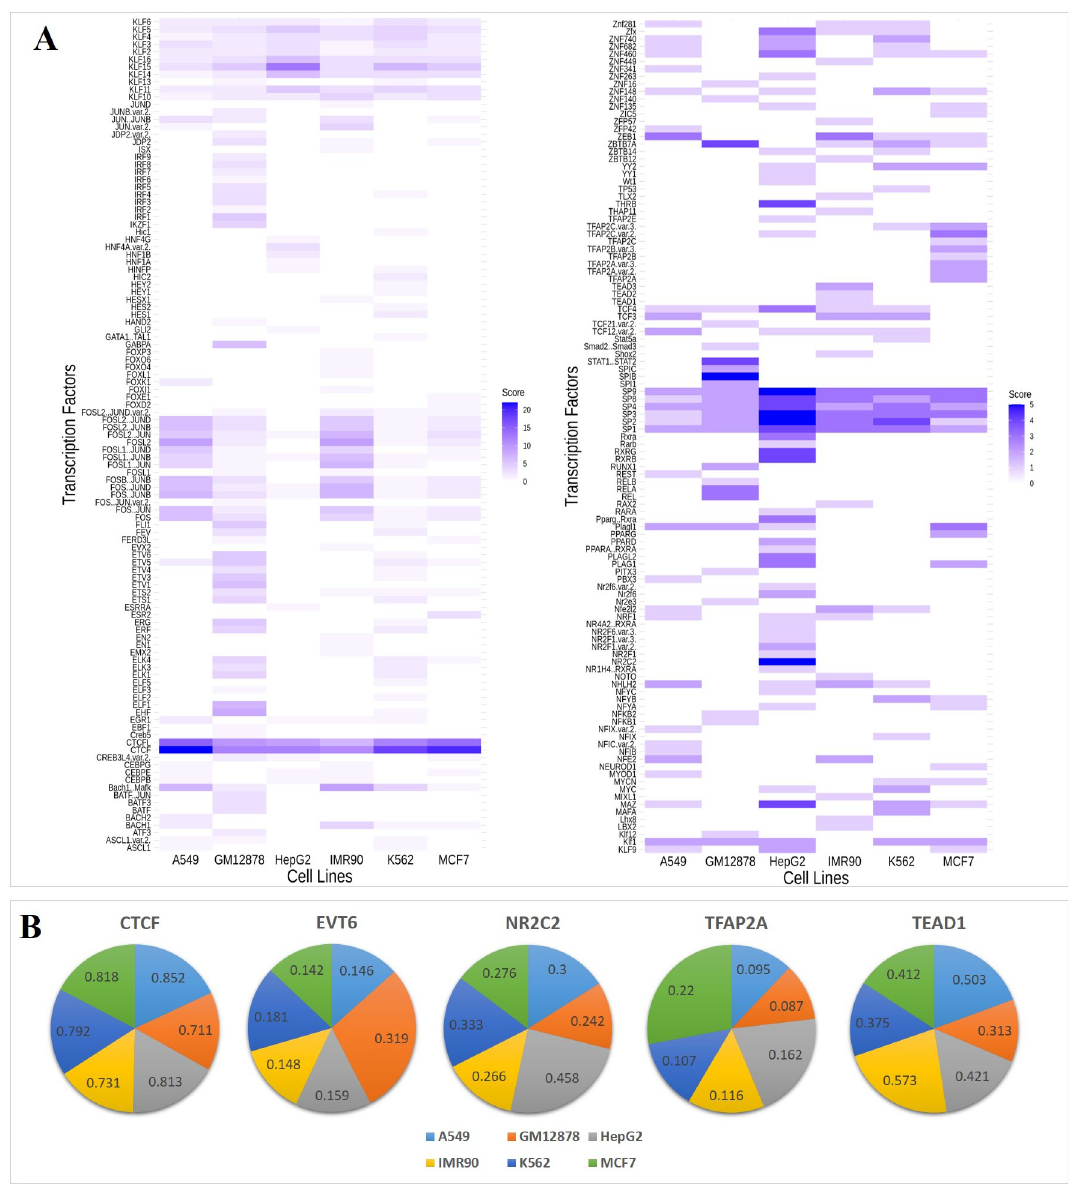
Fig 6. The enrichment of different TFBSs in the six cell lines. (A) The heat maps of diverse motifs in the six cell lines. CTCF binding motif is enriched in all six cell lines. EVT6, NR2C2, TFAP2A, and TEAD1 binding motifs are enriched in the GM12878, HepG2, MCF7, and IMR90 respectively. (B) The intersection ratio between the above five TFs ChIP-seq peaks and the ATAC-seq peaks of the six cell lines. The intersection ratio of CTCF to the six cell lines is all very high (mean: 0.786) corresponding to the observation that CTCF binding motif is enriched in all six cell lines. The maximum intersection ratio of the other four TFs is 0.319, 0.458, 0.22, and 0.573, corresponding to the GM12878, HepG2, MCF7, and IMR90 cell lines